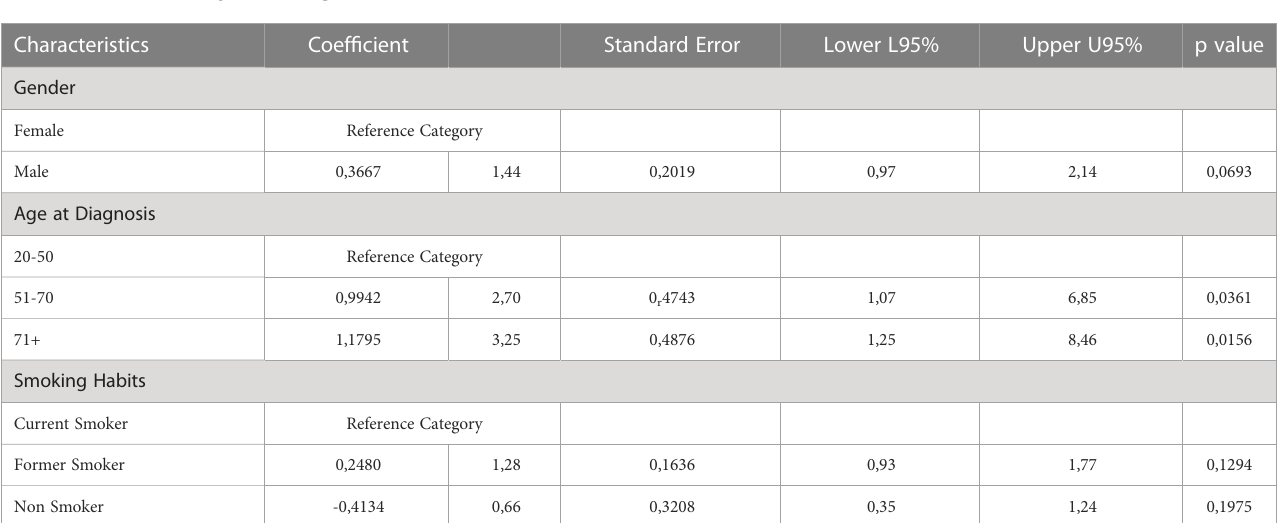
TABLE 3 Multivariate analysis - Cox regression